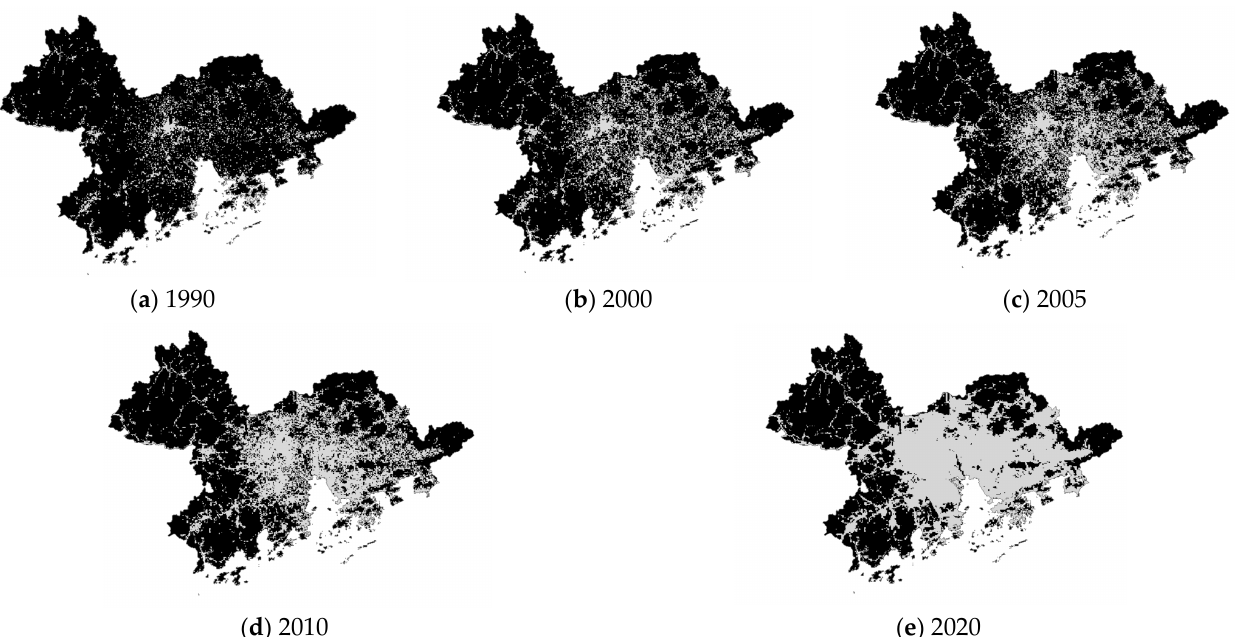
Figure 3. Impervious surface area of the Greater Bay Area.